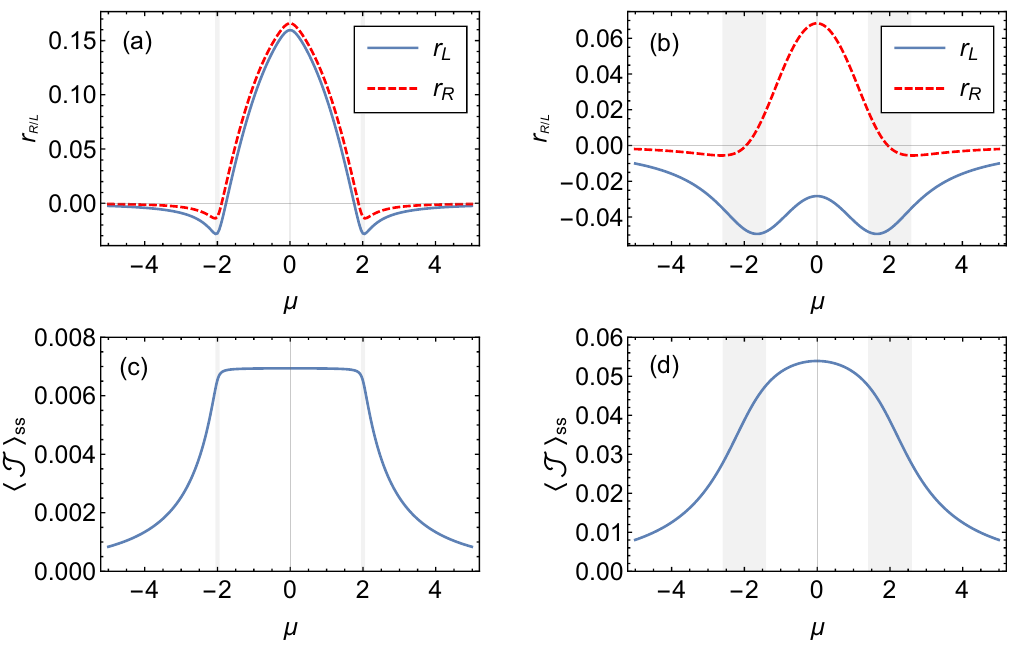
Figure 4: Top: edge occupation ratios in the steady state, as defined in eq. (30), under OBC with N = 100. (a) shows weak dissipation ( g = 0.1) while (b) has stronger dissipation ( g = 1.0). The latter shows a smoother transition and a large asymmetry between the left and right edge. Bottom: steady state current 〈 J 〉 under PBC, with weak (c) and strong (d) dissipation. Shaded regions have broken AUS. The remaining parameters are: J = 1, γ = 0.8, and ∆ =